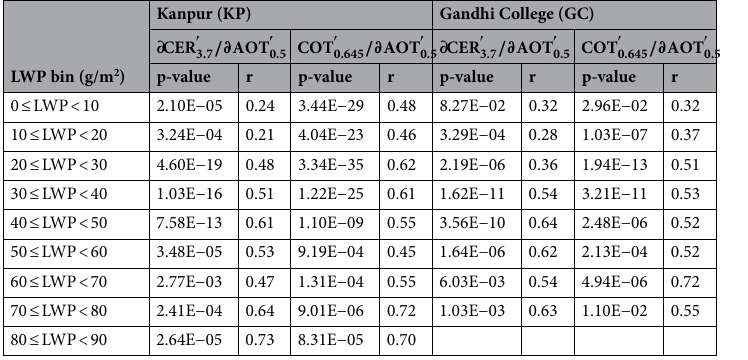
Figure 1. Values of ( a ) ∂ CER meteorological factors through multiple linear regression for LWP bins of 10 g/m 2 spectrum for Kanpur (KP) and Gandhi College (GC) sites, where CER 3.7 µm, COT at 0.645 µm and AOT at 0.5 µm, respectively.